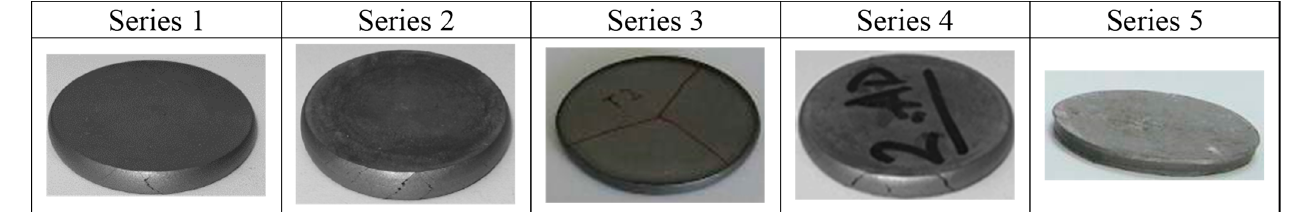
Figure 3. Typical geometric changes after each increment of the die’s displacement (Series 5). The experimental strain paths determined in five series of the upsetting process (Ta- ble 1) according to the procedure described in the previous section are depicted in Figure 4. The leftmost points correspond to the instant of fracture initiation. The corresponding values of f θ ε and